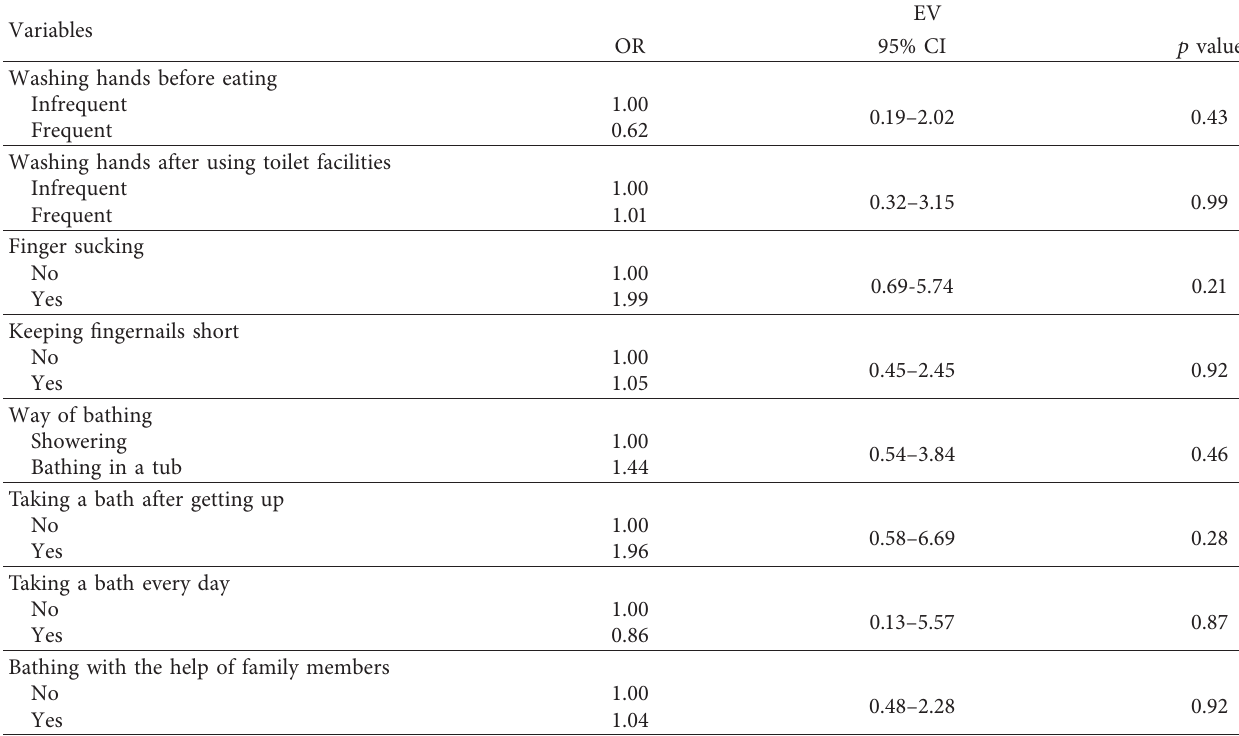
Table 2: Logistic regression analysis of personal hygiene associated with Enterobius vermicularis infection among primary schoolchildren in the Marshall